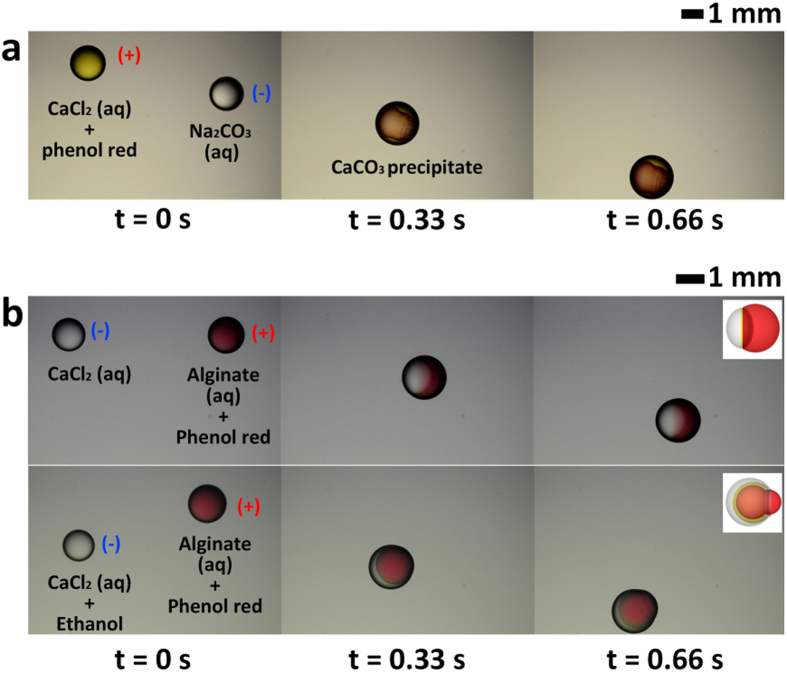
(a) Chemical reaction for precipitate formation of CaCO3 by coalescence of oppositely charged droplets of CaCl2 and Na2CO3. (b) Formation of Janus droplet by coalescence of oppositely charged droplets of CaCl2 and SA. The top and bottom rows illustrate formation of Janus droplet with different shapes by the variation in surface tension.